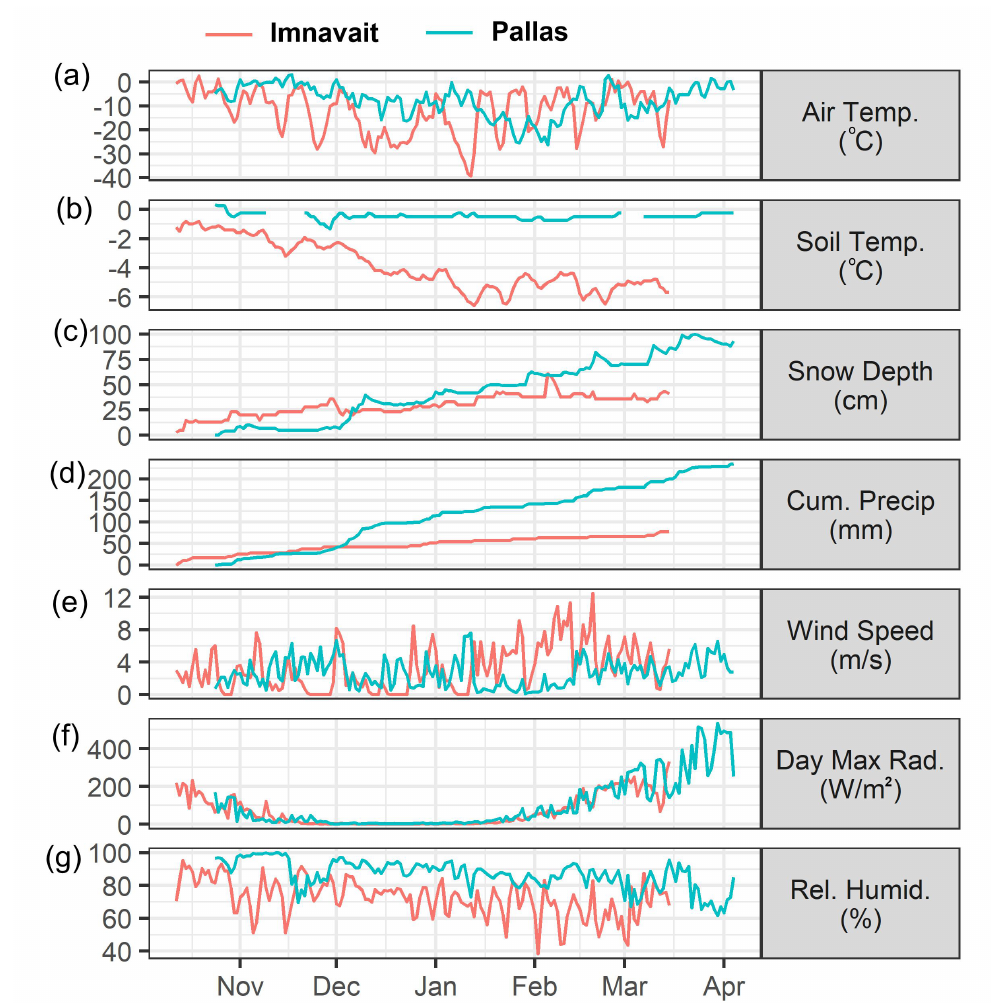
Figure 2. Key meteorological variables for daily ( a ) mean air temperature, ( b ) mean soil temperature, ( c ) maximum snow depth, ( d ) cumulative precipitation, ( e ) mean wind speed, ( f ) maximum short wave radiation ( g ) mean relative humidity for winter 2018–2019 at the study sites, with Imnavait in red and Pallas in